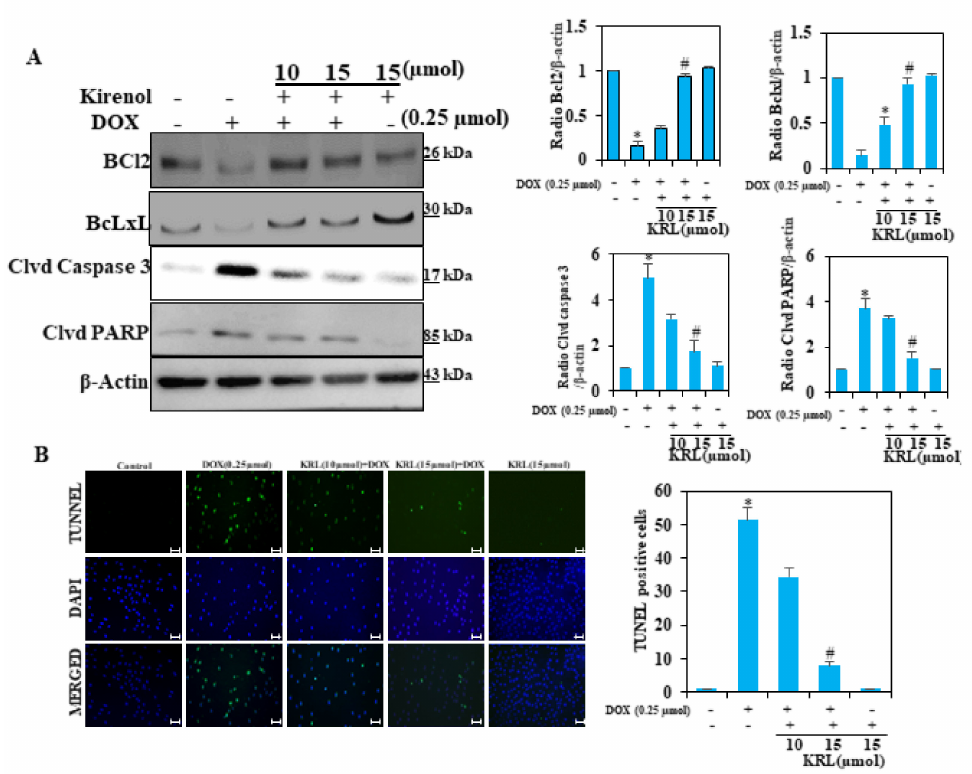
Figure 6. KRL inhibits DOX-induced apoptosis in cardiomyocytes. ( A ) Cells were pretreated with 15 µ mol of KRL for 2 h followed by DOX (0.25 µ mol for 24 h). The expression levels of anti-apoptotic Bcl2 and Bcl-xL and apoptotic proteins cleaved caspase-3 activation and PARP cleavage were measured by the Western blot method. ( B ) Apoptotic nuclei were detected by terminal deoxynucleotidyl transferase dUTP nick-end labeling (TUNEL) staining and the nuclei were detected by DAPI staining, showing modulations in apoptotic levels with DOX against and with KRL. Scale bar indicated 100 µ m at 20 × magnification. Data are represented as the mean ± SD of triplicate values ( n = 3) and * p < 0.05 represents significant variations compared with the control. # p < 0.05 represents significant variations as compared to DOX alone and KRL with DOX treatment